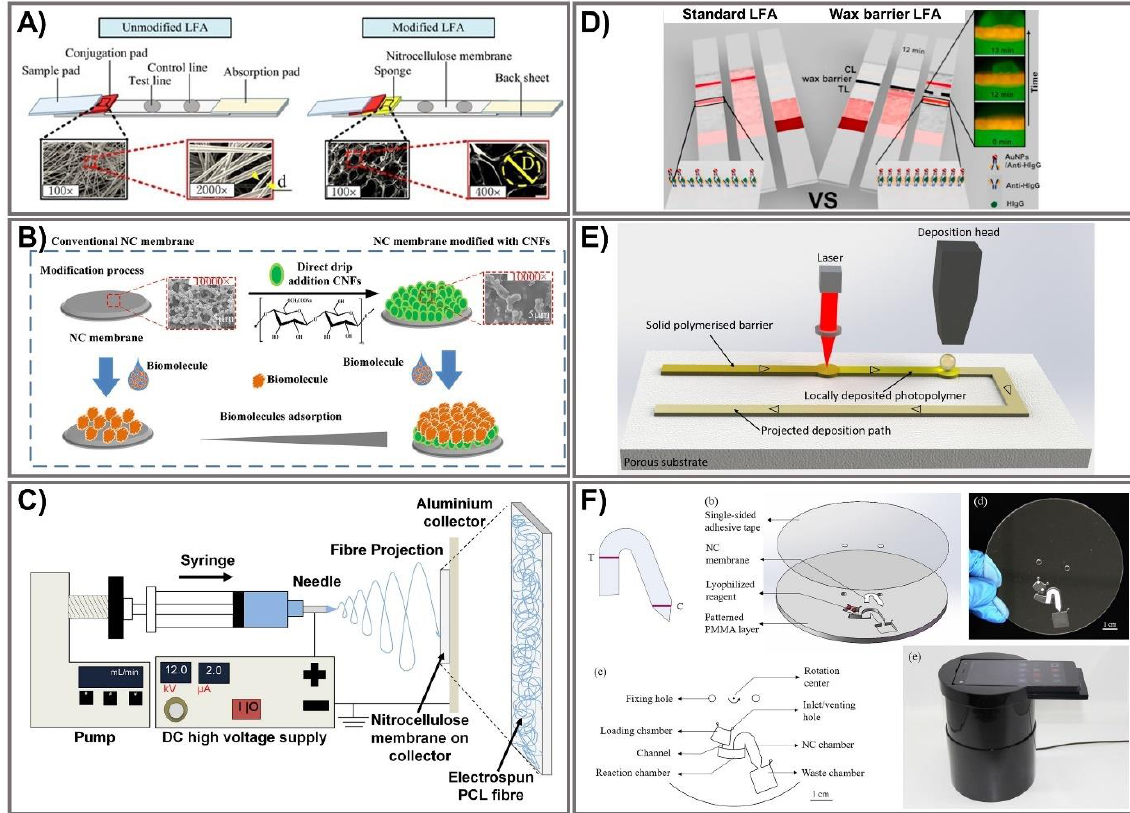
Figure 9. PAD engineering for signal amplification. ( A ) Integration of a sponge shunt into LFA to decrease the fluid flow rate. Adapted with permission from Ref. [174] . ( B ) Modification of an NC membrane with cellulose nanofibers to increase biomolecule adsorption. Adapted with permission from Ref. [190] . ( C ) Direct deposition of polycaprolactone fibers on an NC membrane using electrospin. Adapted with permission from Ref. [191] . ( D ) LFA modified with a wax barrier to de- crease the flow rate after the test line. Adapted with permission from Ref. [192] . ( E ) Laser-based direct-write procedure for localized deposition of a photopolymer to create polymerized hydrophobic structures in the porous substrate. Adapted with permission from Ref. [193] . ( F ) Centrifugation-assisted LFA system to control flow rate, including (a) patterned NC membrane, (b) configuration of the centrifugation disc, (c) patterned PMMA layer, (d) assembled LFA disc, and (e) smartphone-based operating devices. Adapted with permission from Ref. [194] . As an alternative to the sponge shunt, Pereira et al. successfully integrated the con- centration and detection steps into a single step that occurs entirely within a portable pa- per-based diagnostic strip. The Triton X-114 micellar aqueous two-phase system (ATPS) was applied to a 3D paper design and effectively reduced the separation time from 8 h to